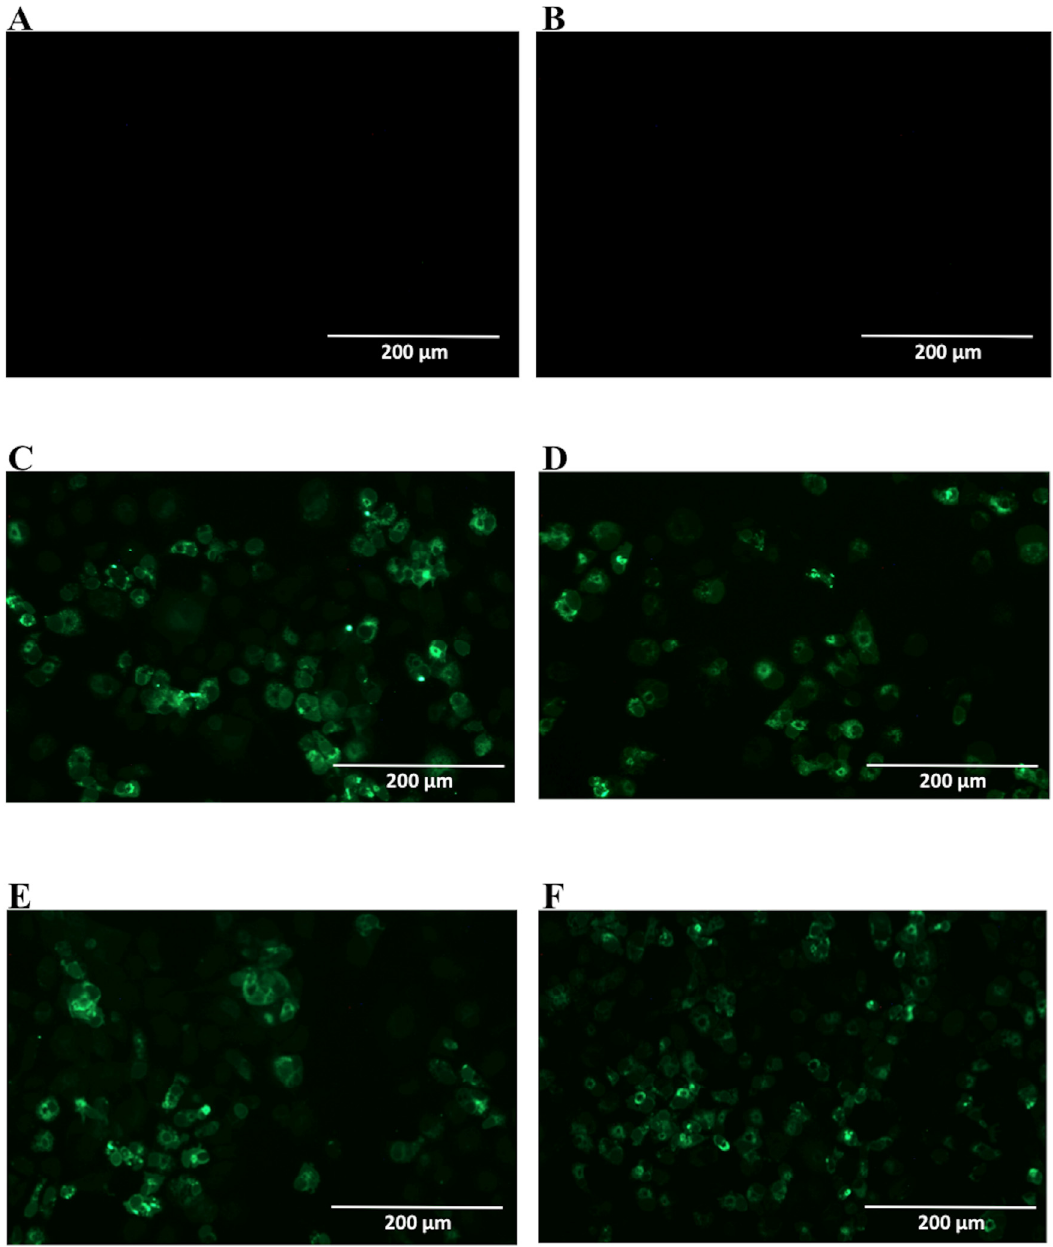
Figure 2. Reactivity of NS1-specific mAbs to dengue-serotype 2-infected Vero cells. Cells were infected with a multiplicity of infection (MOI) of 0.5, fixed, permeabilized and treated with each of the tested mAbs 48 h post infection. Then, cells were labeled with Alexa fluor ® conjugated goat-anti mouse IgG. The negative controls: Mock-infected cells treated with a pool of mAbs anti-NS1 ( A ) and DENV2-infected cells labeled only with secondary antibody ( B ); Tested mAbs: ( C ) 4F6; ( D ) 4H2; ( E ) 2H5 and ( F ) 4H1BC. Magnification of 200×.